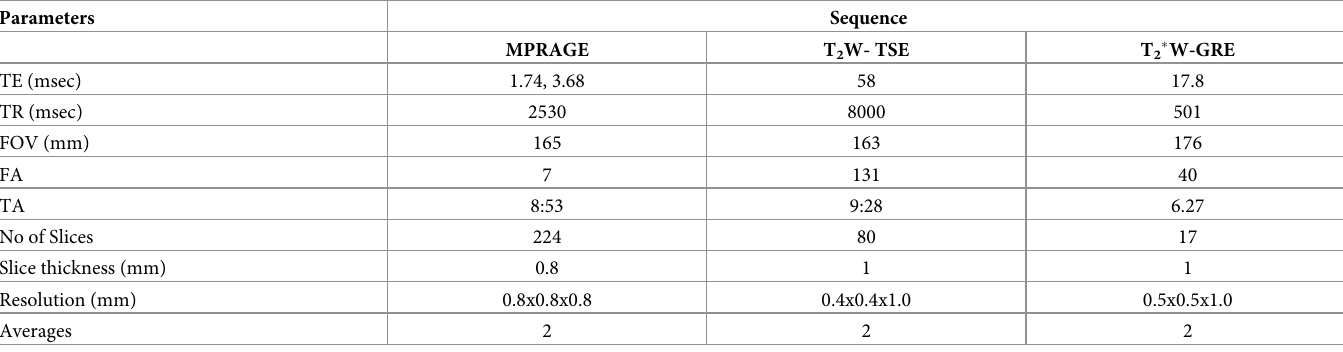
Table 2. Sequence parameters for image artifact